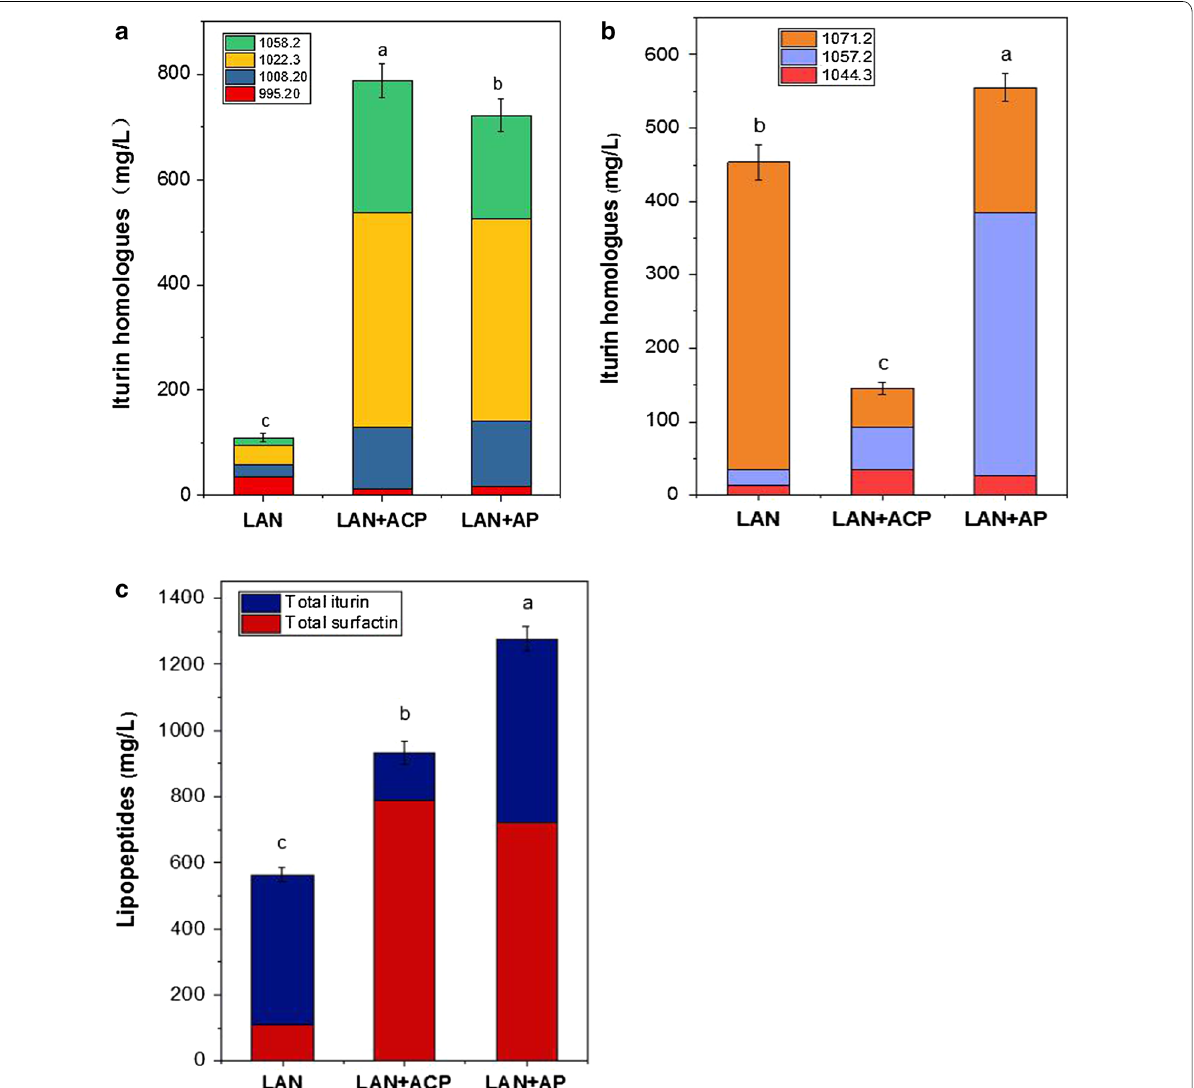
Fig. 5 Effect of activated carbon powder (ACP) and attapulgite powder (AP) addition to Landy medium on surfactin homologue concentrations ( a ), iturin homologue production ( b ), and lipopeptides production ( c ). Values are mean between treatments (p <